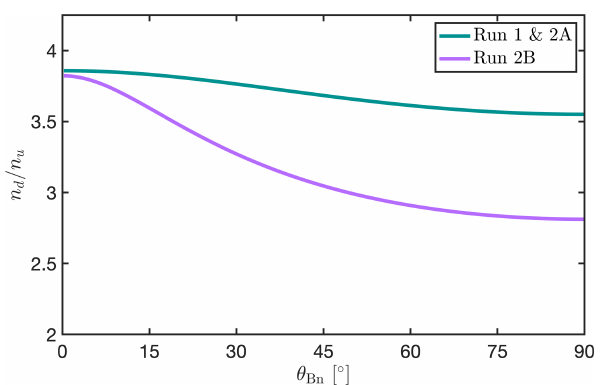
Figure 5. Density compression ratio as a function of θ Bn for two different M A values, corresponding to those in the simulation